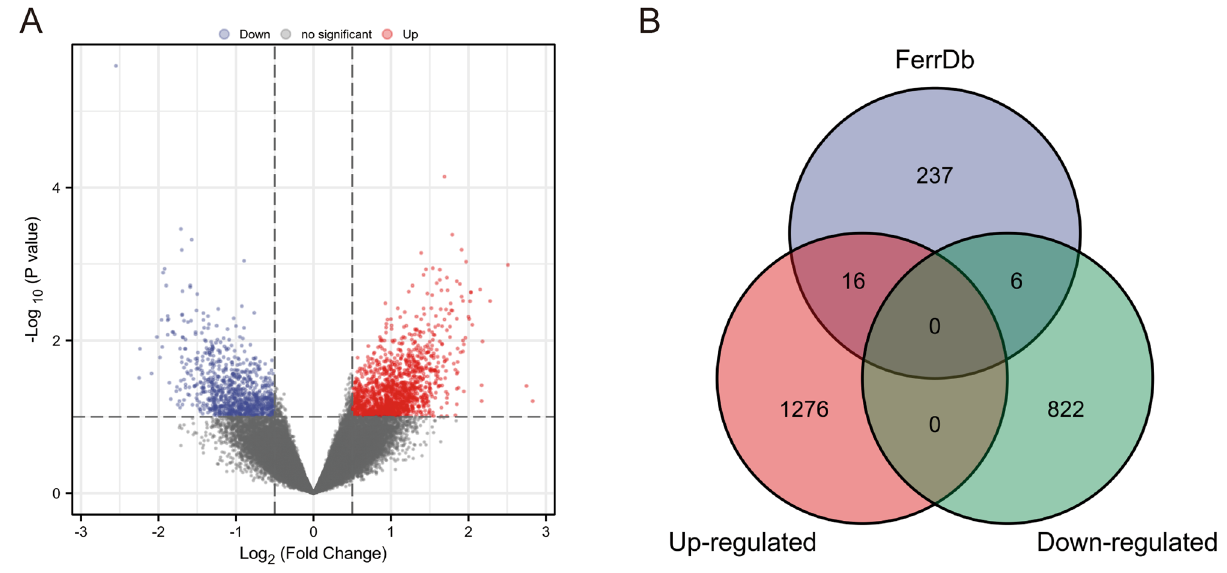
Figure 1. Ferroptosis-related DEGs identification in chemoresistance OS patients. ( A ) The volcano plot of differential analysis in the GSE87437 dataset. ( B ) The Venn diagram obtained by intersecting the DEGs in the GSE87437 dataset and ferroptosis-related genes in the FerrDb database.